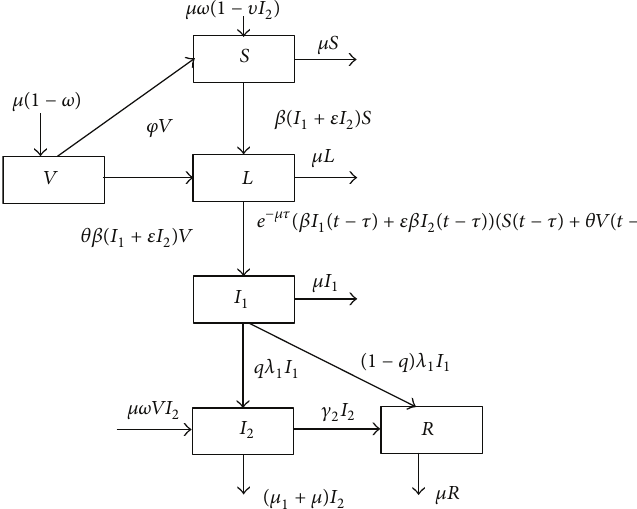
Figure 1: Flow diagram of HBV transmission in a